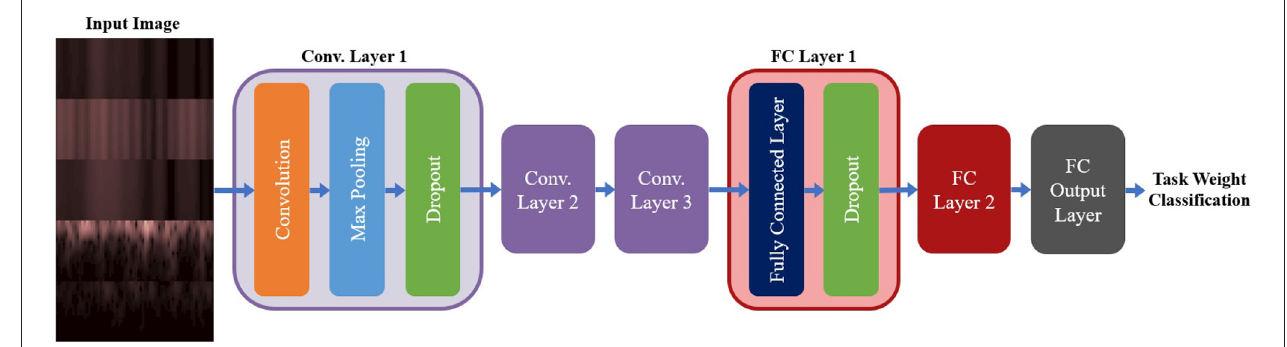
FIGURE 5 | The base model configuration used for all three spectrogram CNN model types. All spectrogram model types used three convolution layers, followed by two FC layers and an output FC layer to perform the final classification. Each convolution layer had three sub-layer steps (convolution, max pooling, and dropout) and each FC layer had two sub-layer steps (the FC step followed by dropout). Note, that repeated layers only show the sub-layers for the first layer, to reduce redundancy and condense the